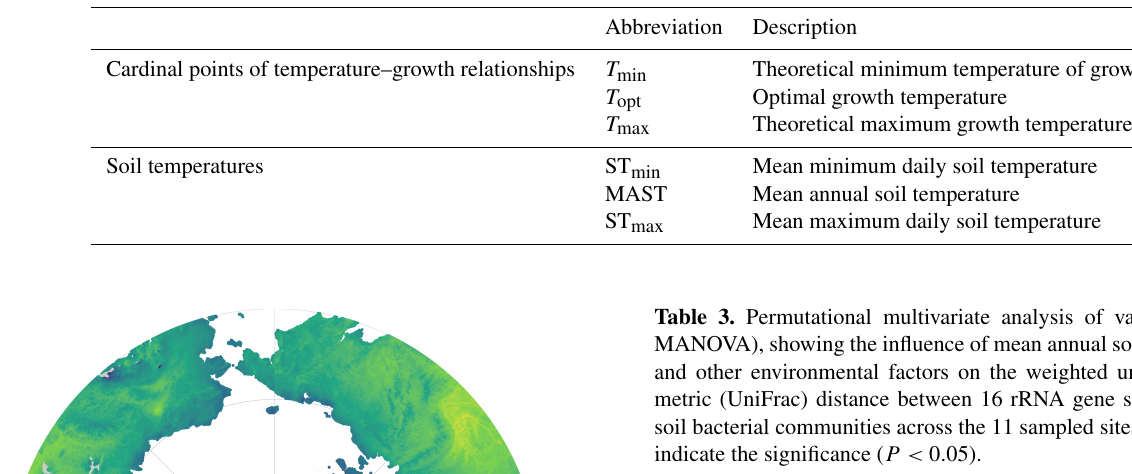
Table 2. Description of the abbreviations used to described temperature–growth relationships and soil thermal regimes.